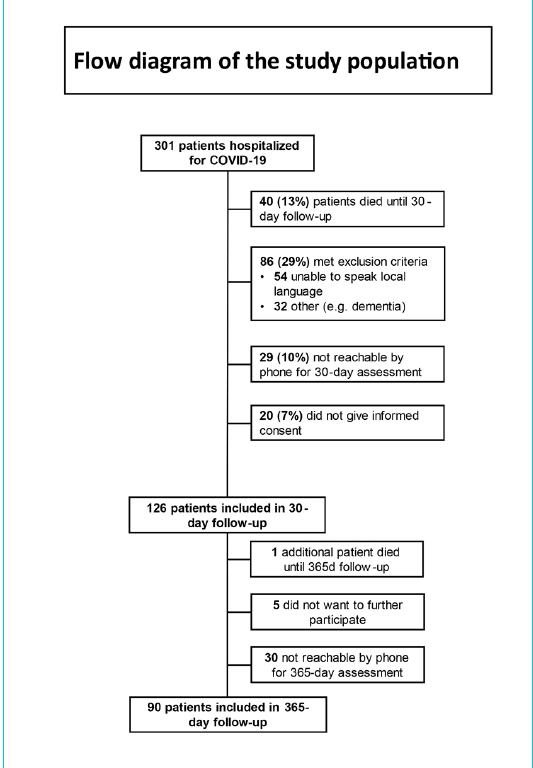
Figure 1: Flow diagram of the study